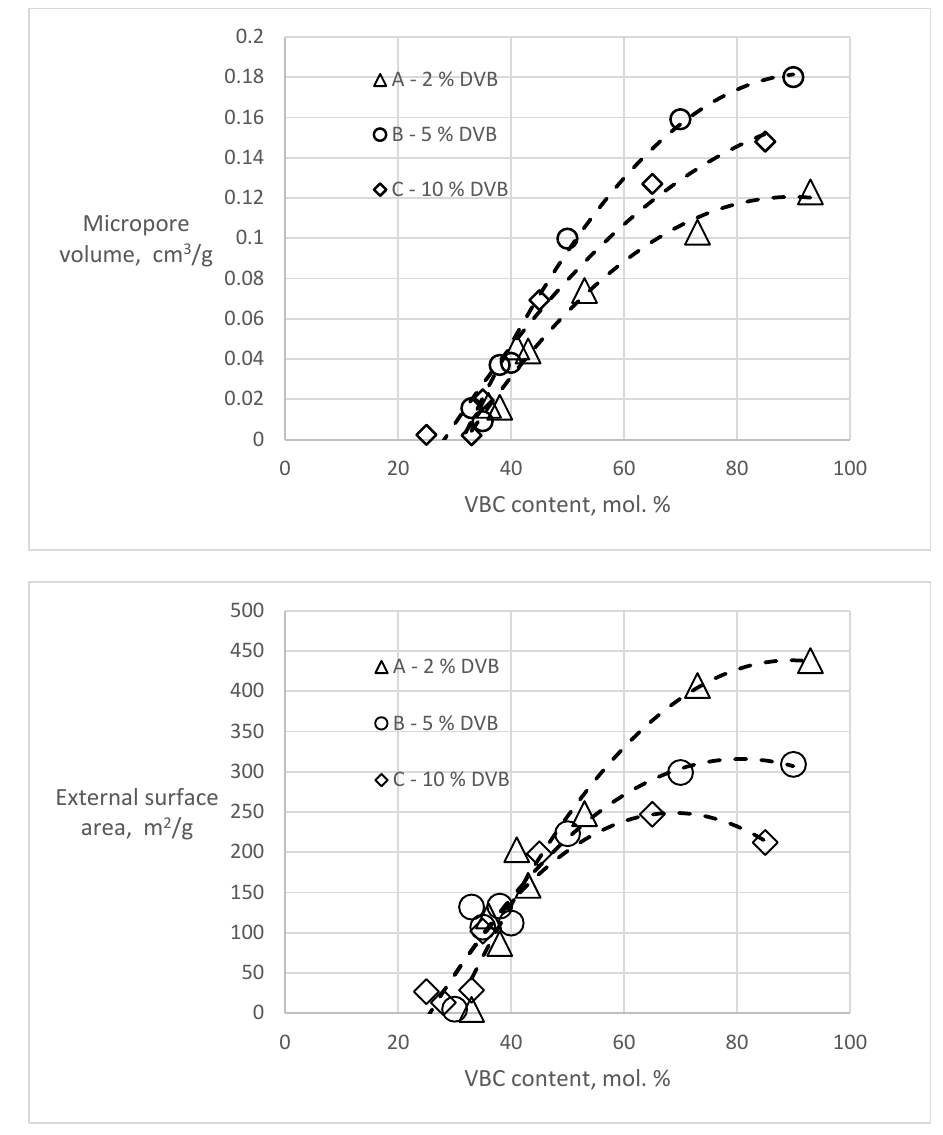
Figure 3. Dependencies of micropore volume and external surface area in the hypercrosslinked polymers on the content of VBC .